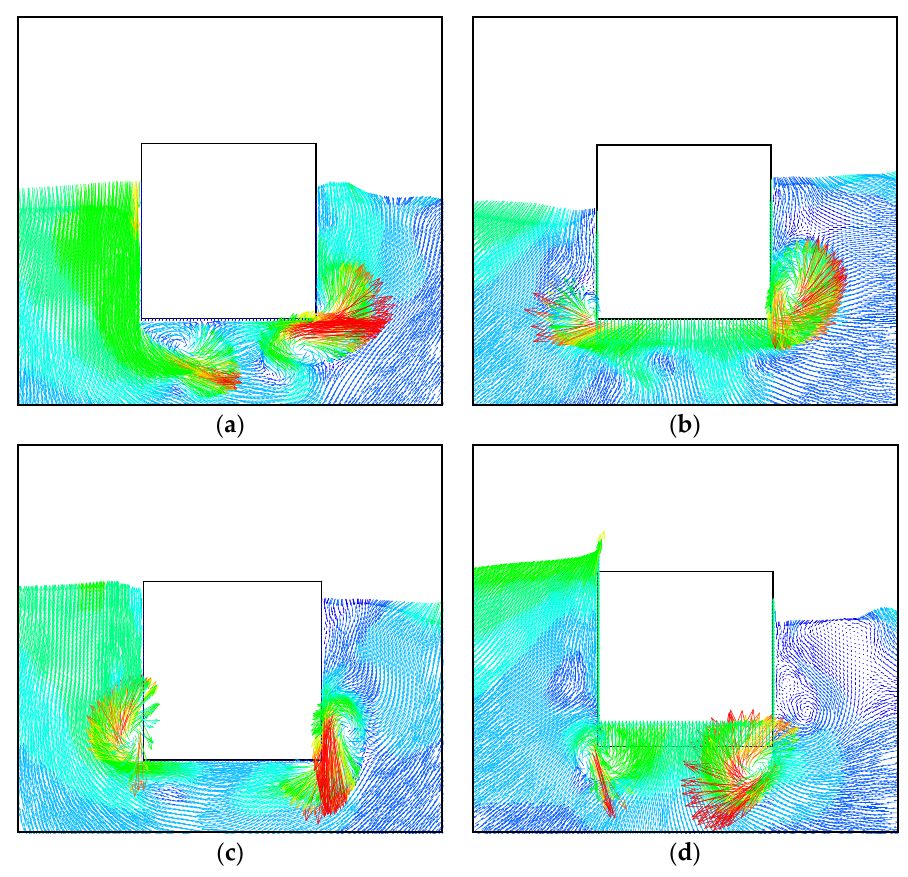
Figure 14. Flow fields around the buoy in a wave cycle ( S = 0.75, H = 0.1 m, T = 1.75 s): ( a ) t = T/4; ( b ) t = 2T/4; ( c ) t = 3T/4; ( d ) t = 4T/4.